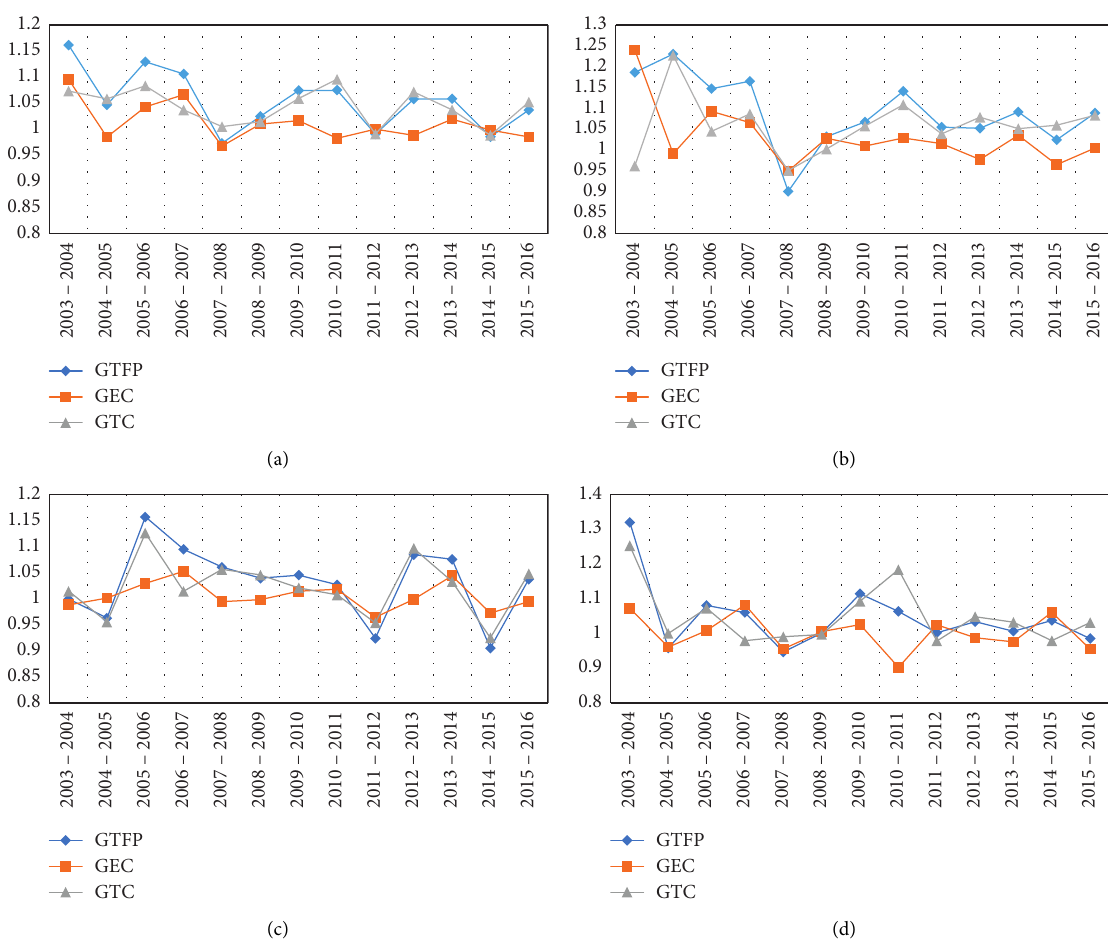
Figure 4: Industrial green total factor productivity and its decomposition. Manufacturing industry (a), heavy pollution industry (b), slight pollution industry (c), and moderate pollution industry